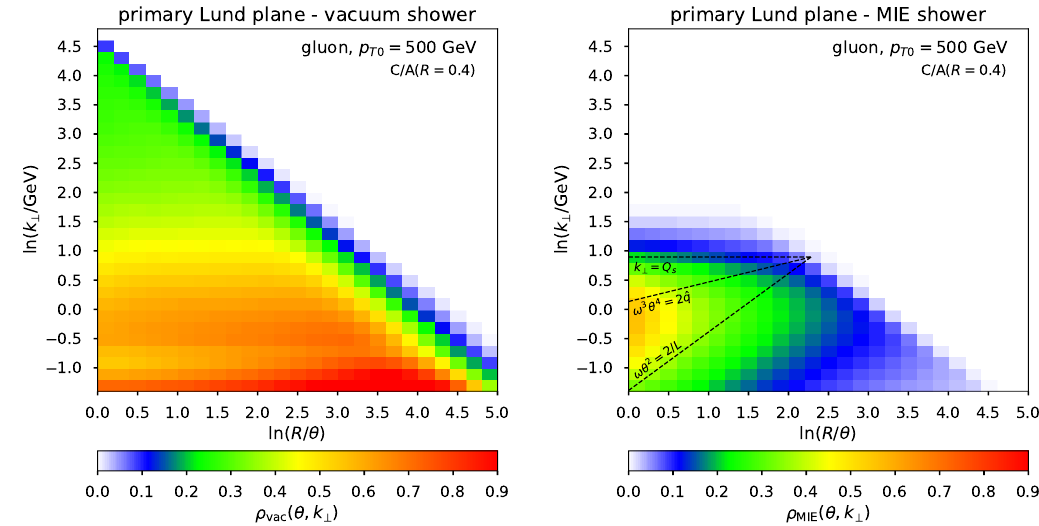
Figure 2 . Plot of the primary Lund plane density (cid:26) for the two main showers in our Monte Carlo: the vacuum shower (left) and the medium-induced shower (right). In both cases, the shower is initiated by a 500 GeV